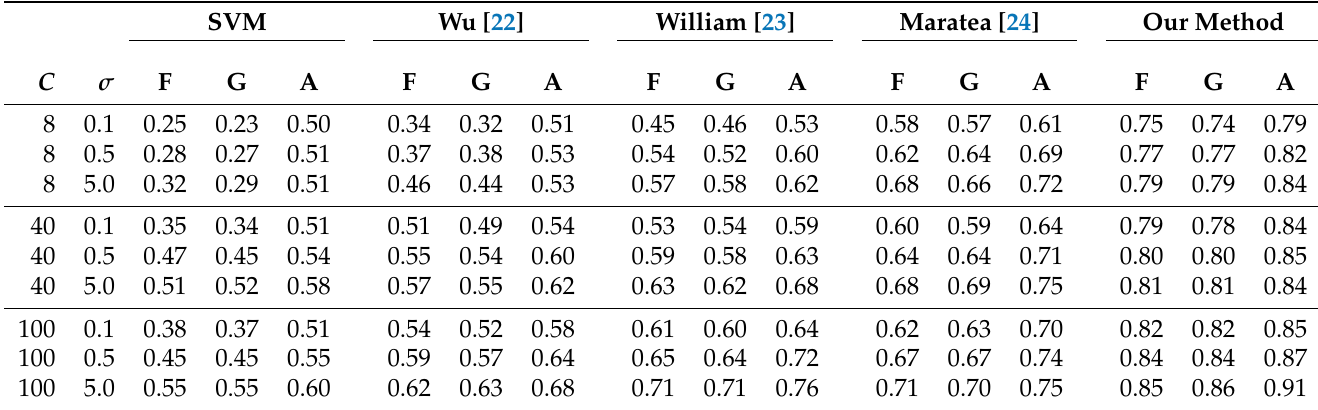
Table 3. F -score (F), G -mean (G) and the AUC (A) measures for all five classification methods in Scenario 3 for n 1 = 20, n 3 = 100 and n 3 = 480, respectively. Max margin is